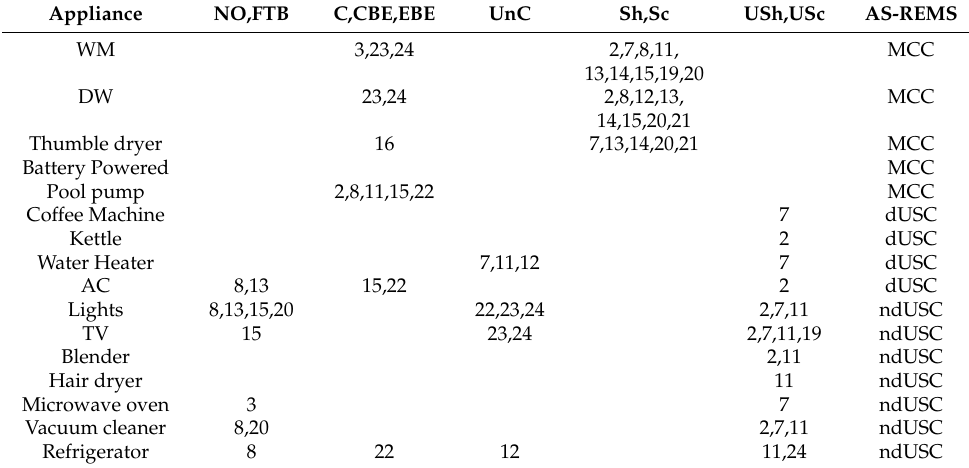
Table 2. Types of classifications at REM studies in the